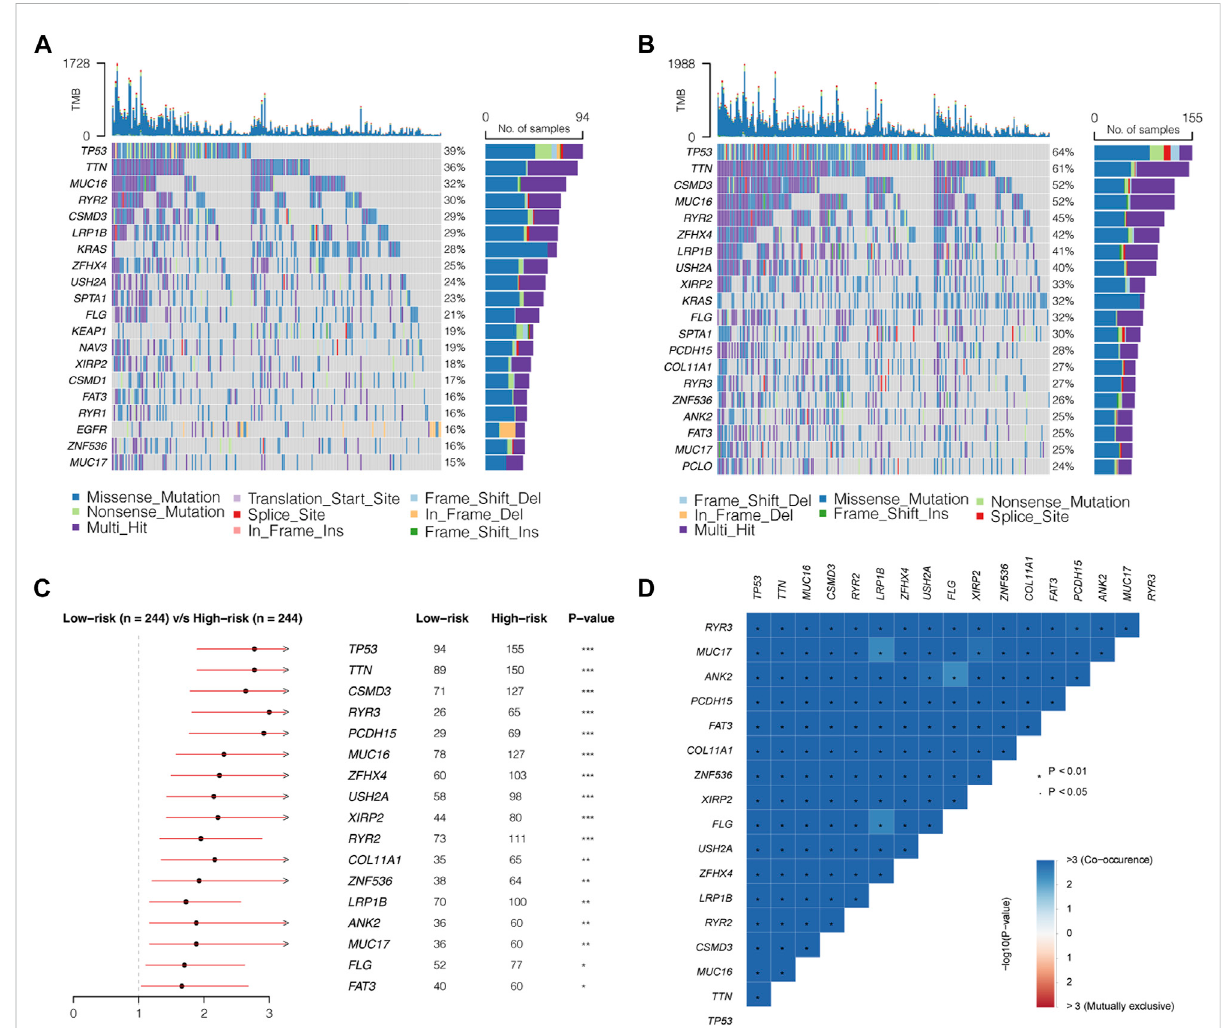
FIGURE 8 Mutation landscapesoflow-andhigh- riskgroups. (A,B) Waterfalldiagrams displaying20geneswith thehighestmutationratesinthelow-and high-risk groups. (C) Seventeen genes mutating differently in the two groups. (D) Correlations of 17 differently mutating genes. Red represents co- occurrence, and blue represents mutually